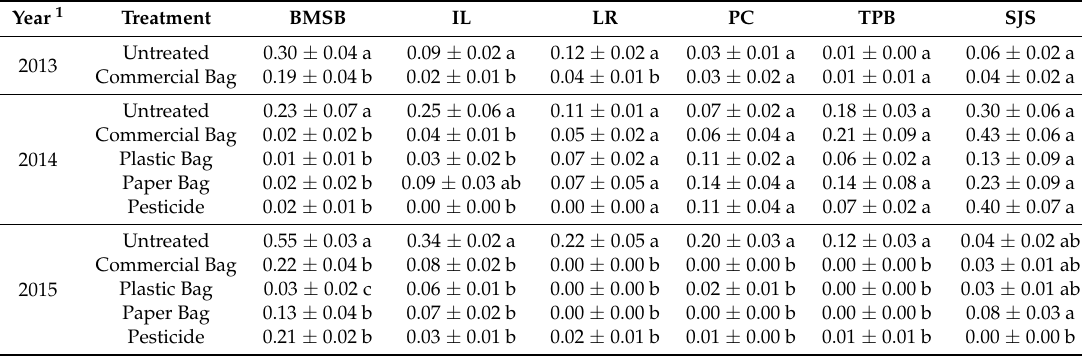
Table 4. Mean ( ± SE) proportion of fruit damaged by insect